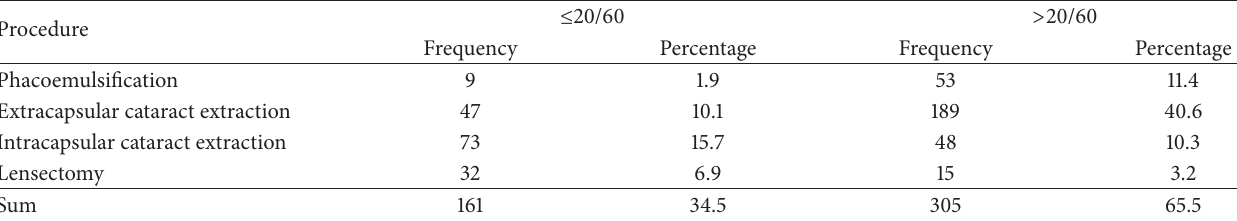
Table 4: Final VA of different cataract removal